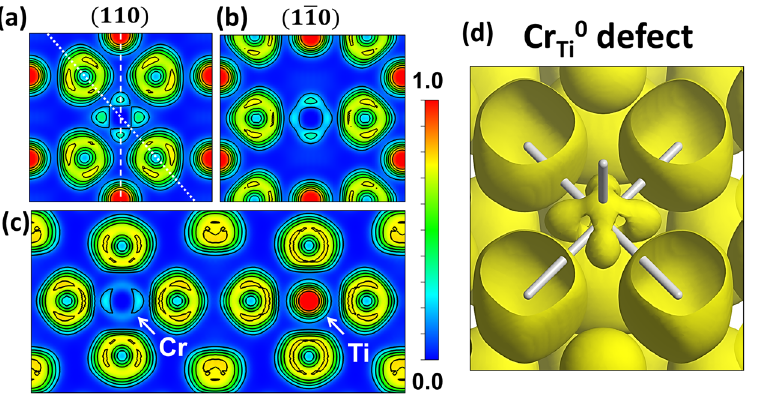
Figure 3. ELF cross section along the ( a ) (110) plane, ( b ) ( 110 ) plane and ( c ) the apical plane perpendicular to (110) for the Cr Ti0 defect. Dotted line in ( a ) represents the intersection with ( 110 ) plane and dashed line represents the intersection with the apical plane. ( d ) Isosurface for an ELF = 0.15 for the Cr Ti0 defect. Cr–O bonds are represented as white